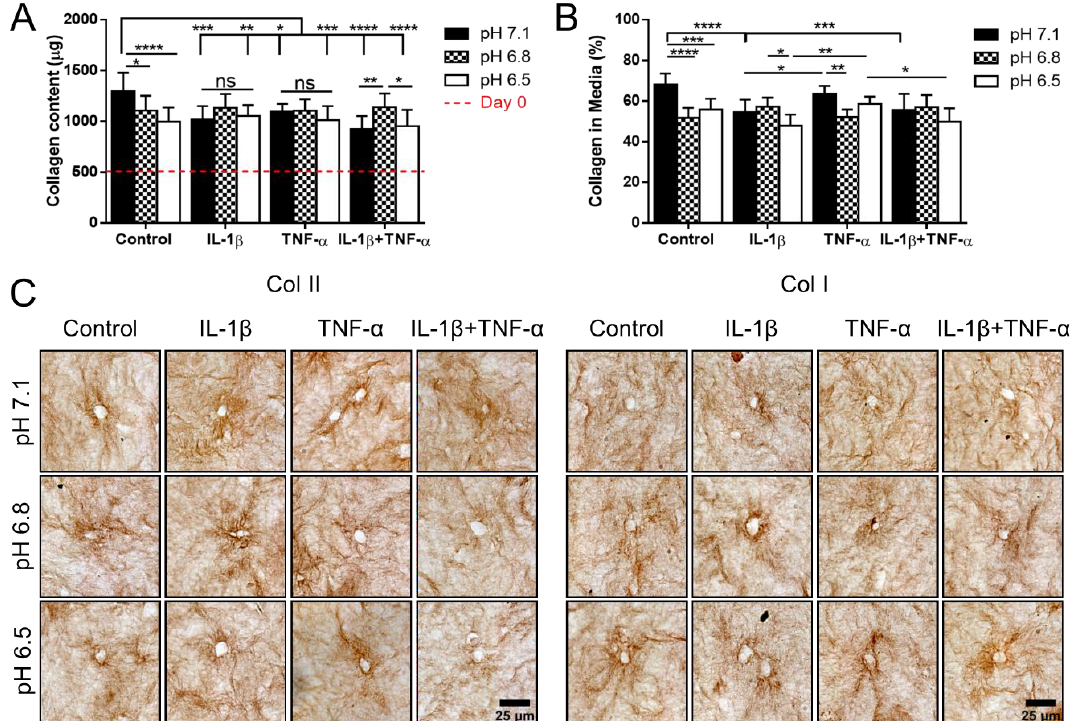
Figure 3. ( A ) Total collagen content (μg) in hydrogels and media at day 14 cultured in pH modified media (pH 7.1, 6.8 and 6.5) either unsupplemented (control) or supplemented with IL1-β and TNF-α or a combination of both. ( B ) Collagen detected in culture media (%). The values are expressed as a percentage of the total amount of collagen measured at day 14. * ( p < 0.05), ** ( p < 0.01), *** ( p < 0.001) and **** ( p < 0.0001) indicate significant differences between groups, ns (not significant) indicates p ≥ 0.05. N = 3 donors, n = 3 samples. ( C ) Collagen type II and collagen type I immunohistochemical staining. Scale bar is 25μm.